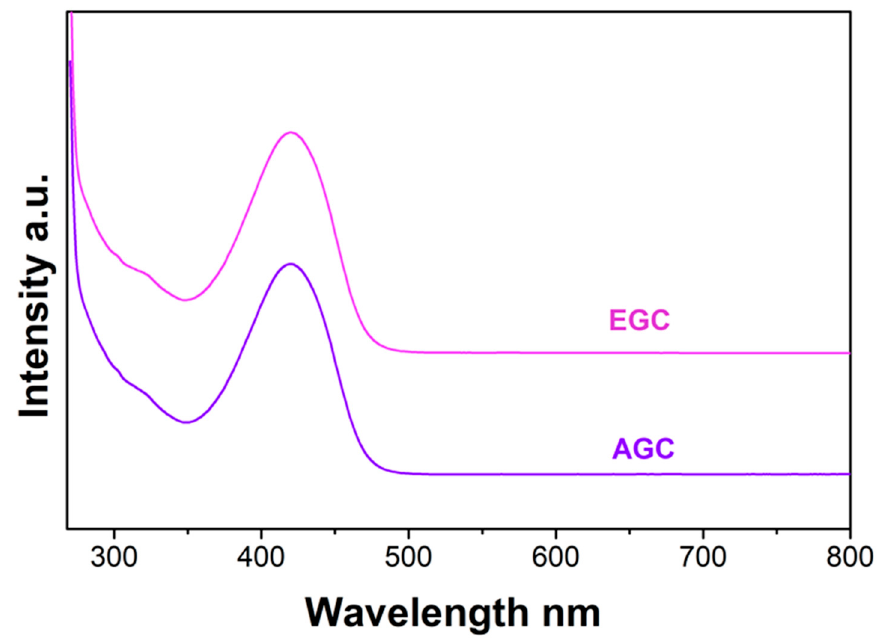
Figure 3. UV–Vis spectra of the yellow fraction of the Asian ( AGC ) and European ( EGC ) inks eluted with chloroform. The spectra have been vertically shifted for a better outlook.